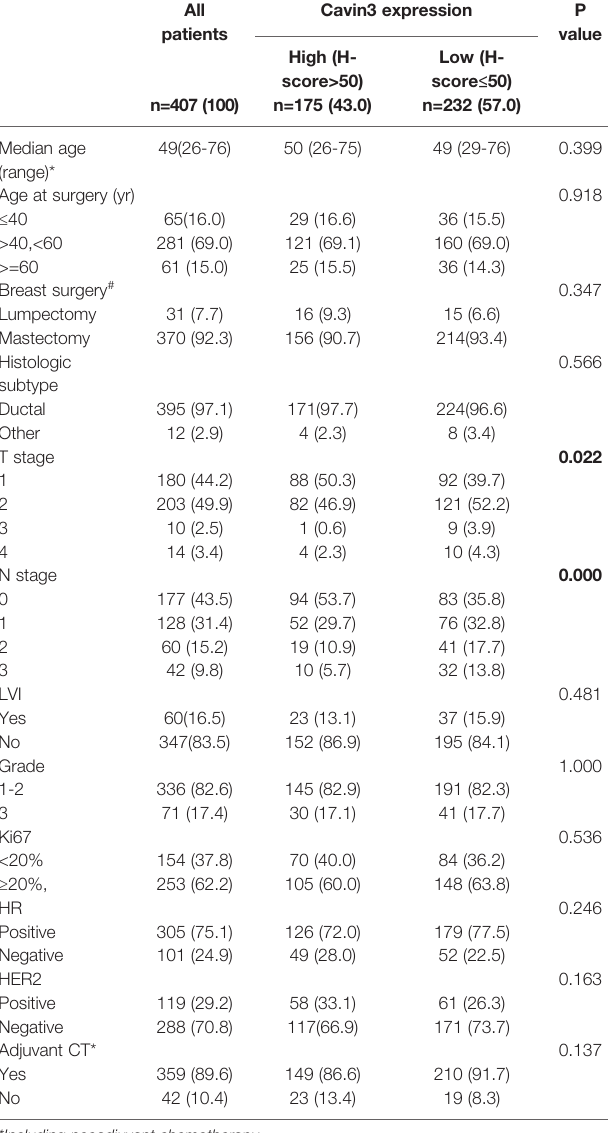
TABLE 1 | Comparison of baseline characteristics between patients with high and low expressions of cavin3. All Cavin3 patients